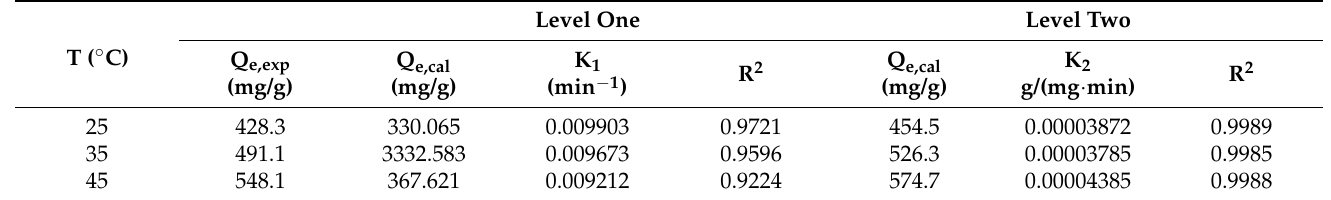
Table 3. Parameters in the pseudo-first-order and pseudo-second-order kinetic